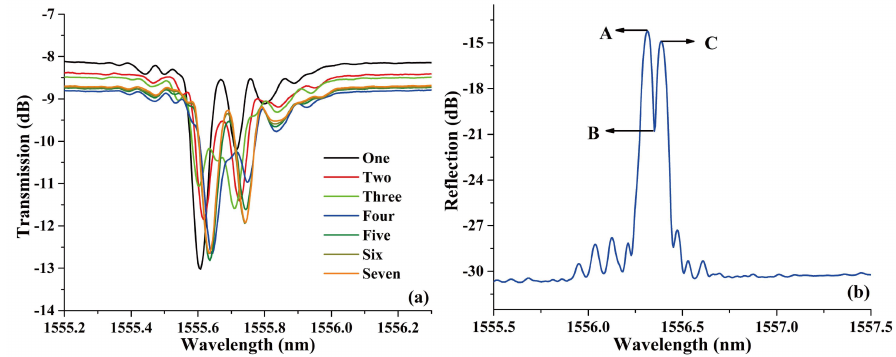
Figure 2. ( a ) The evolutions of the transmission spectrum of the PS-FBG written in the ECF during discharge process, and ( b ) the reflection spectra of the PS-ECFBG by seven